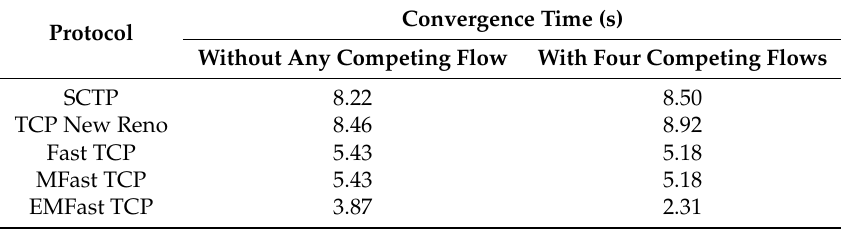
Table 1. Convergence time of the protocols after fast-recovery phase (average for five tests) [Table